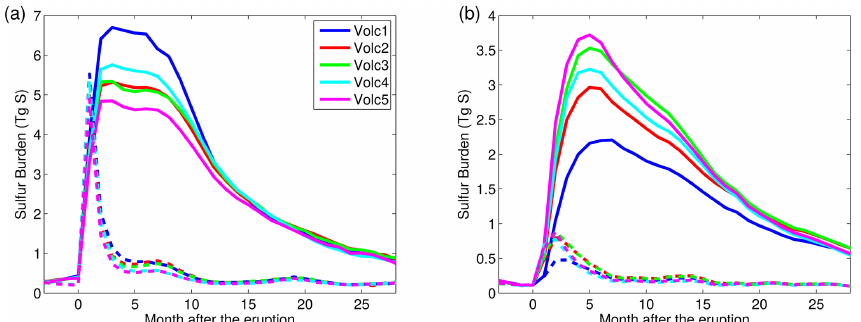
Figure A2. SO 2 (dashed lines) and sulfate (solid lines) burden after the eruption on (a) Northern Hemisphere and (b) Southern Hemisphere. Note different the scales on the y axes.